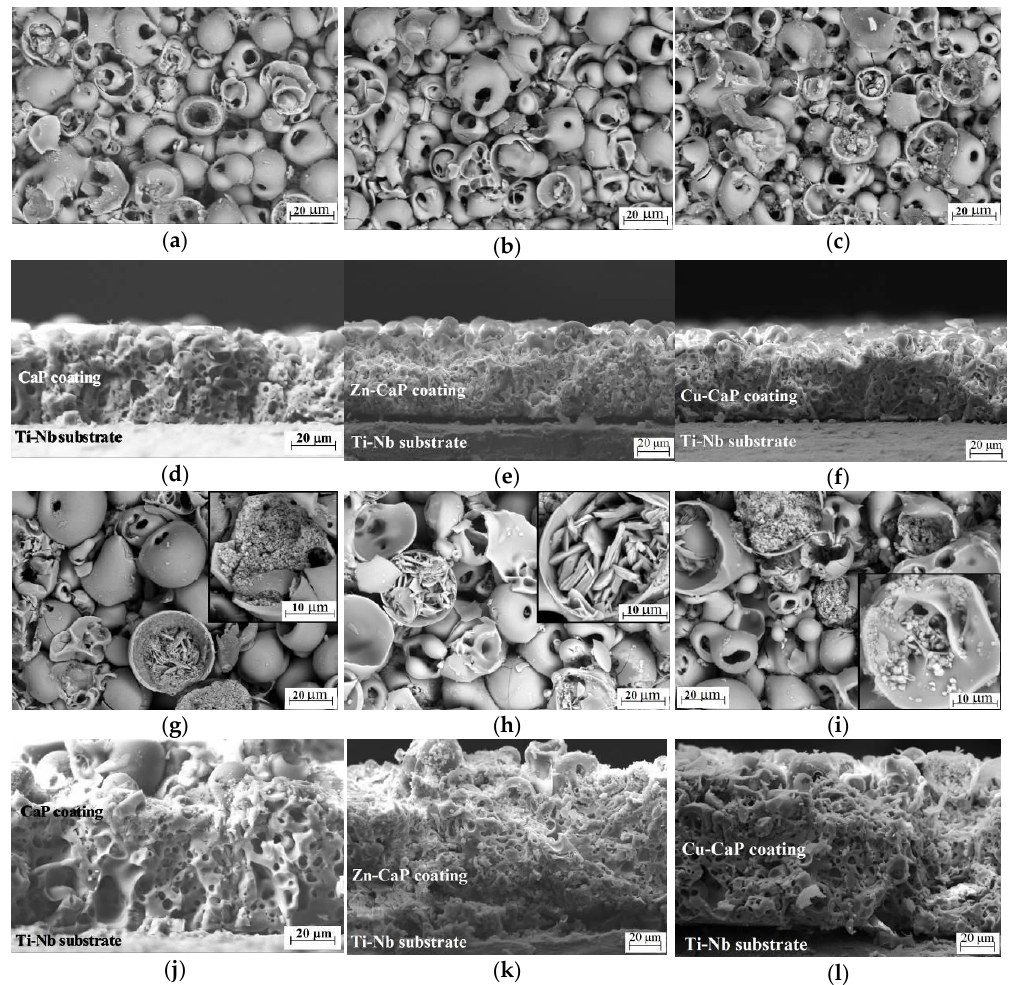
Figure 3. SEM images of the surface and cross-section of the coatings deposited on Ti-40Nb alloy at voltages of 200 V ( a – f ) and 300 V ( g – l ): ( a , d , g , j ) CaP coating; ( b , e , h , k ) Zn-CaP coating; ( c , f , i , l ) Cu-CaP coating.